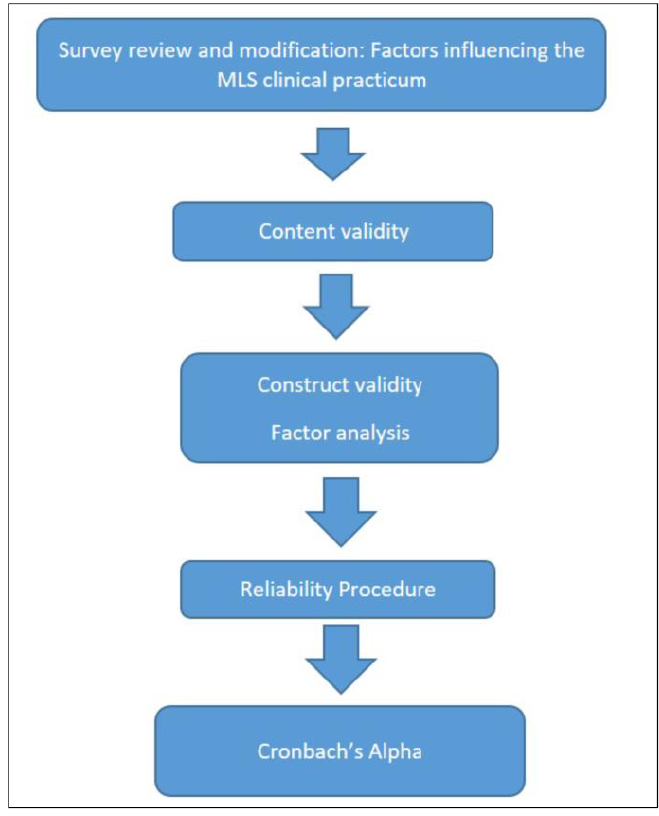
Figure 1. A flow chart depicting the process used for validating the CPAT-QU for the MLS clinical practicum.